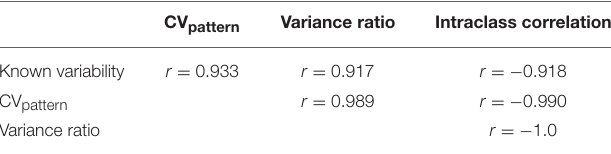
Bold values indicate statistically significant effects. CV, coefficient of variability. TABLE 2 | Pearson correlation coefficients comparing known variability permutations, and CV pattern , variance ratio , and intraclass correlation outputs. CV pattern Known